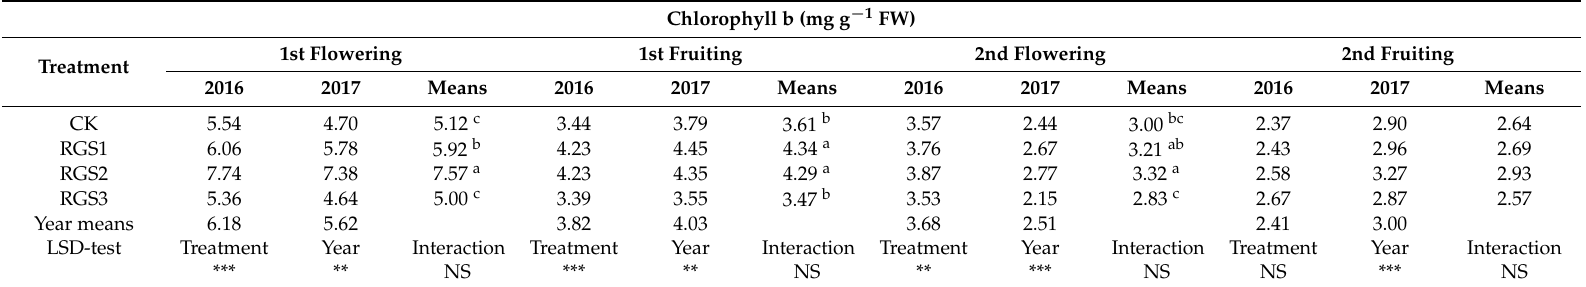
Different letters indicate significant differences between means within columns at p < 0.05 (ANOVA and LSD). ** p < 0.01, *** p < 0.001. NS: Non-significant. Table 2. Effect of amendment with raw garlic stalk on Chlorophyll b content in eggplant